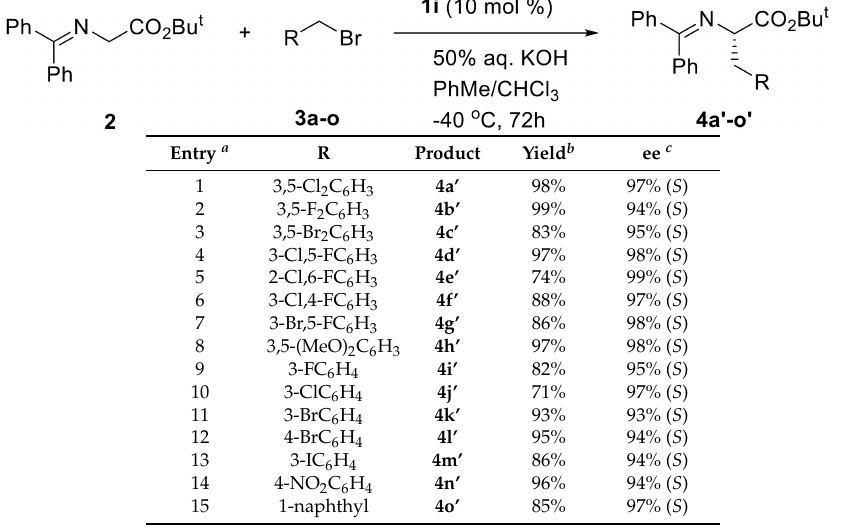
Table 3. Asymmetric alkylation of 2 with 3a-o under the catalysis of 1i